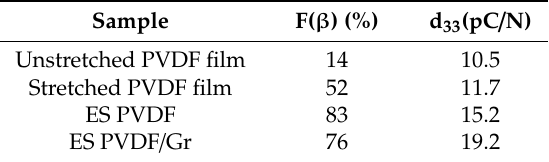
Table 3. F( β ) values and piezoelectric coe ffi cients of the PVDF samples. Reprinted with permission from [110].